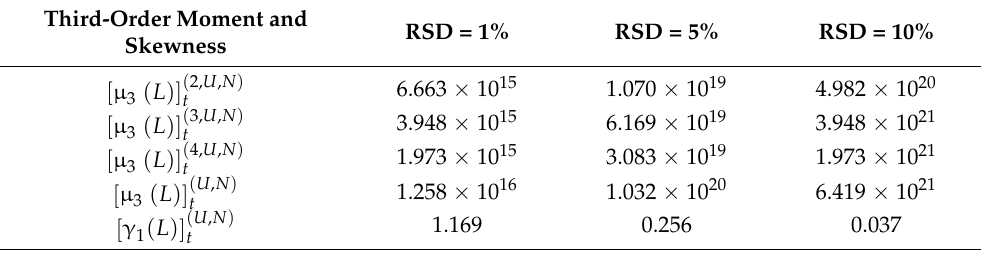
Table 5. Comparison of the third-order response moment and skewness for various relative standard deviations (RSD) of the normally distributed and uncorrelated microscopic total cross sections. Third-Order Moment and RSD = 1% RSD = Skewness